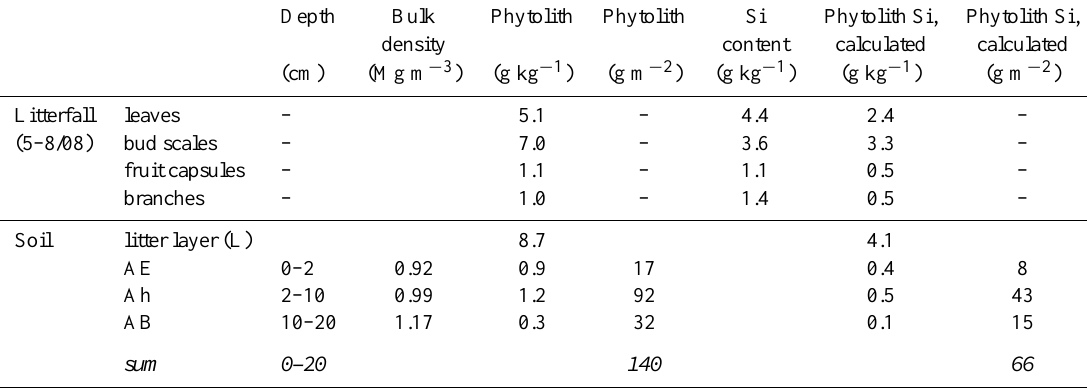
Table 2a. Phytoliths and related Si pools.